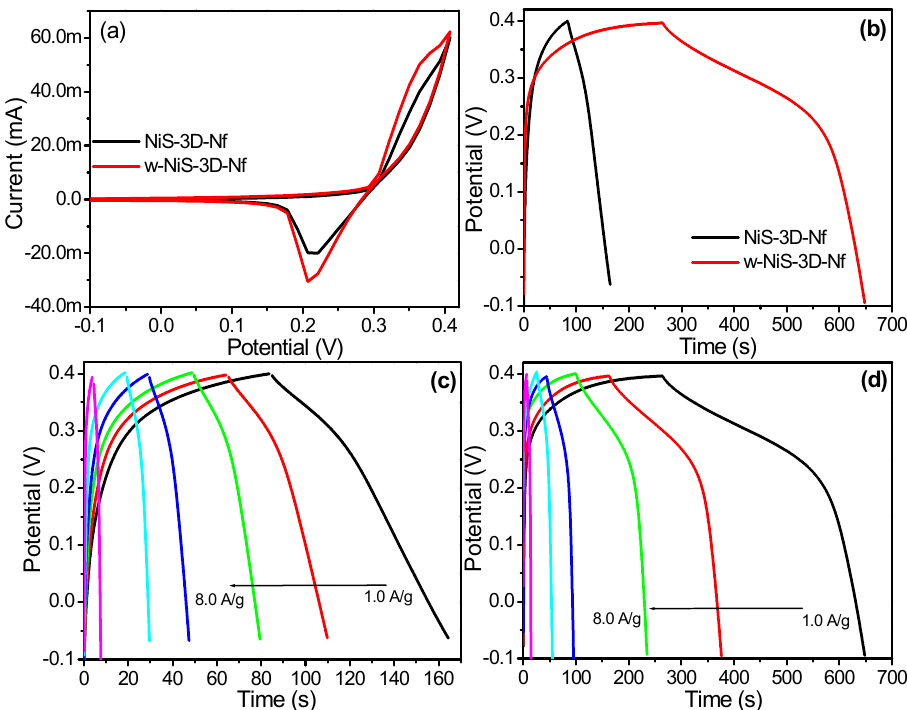
Figure 5. ( a ) Comparative CV graph of the w-NiS-3D-Nf and NiS-3D-Nf electrodes at a fixed scan rate of 10 mV s − 1 , ( b ) comparison of the GCD profiles of the w-NiS-3D-Nf and NiS-3D-Nf electrodes at fixed current density of 1.0 Ag − 1 , ( c ) comparison of the GCD profiles of the NiS-3D-Nf electrode at different current densities, and ( d ) w-NiS-3D-Nf electrode at different current densities.